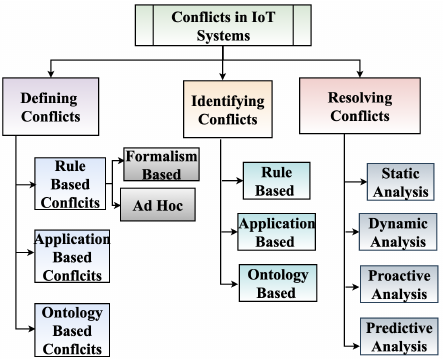
Figure 2. Overview of literature survey on conflict detection and resolution